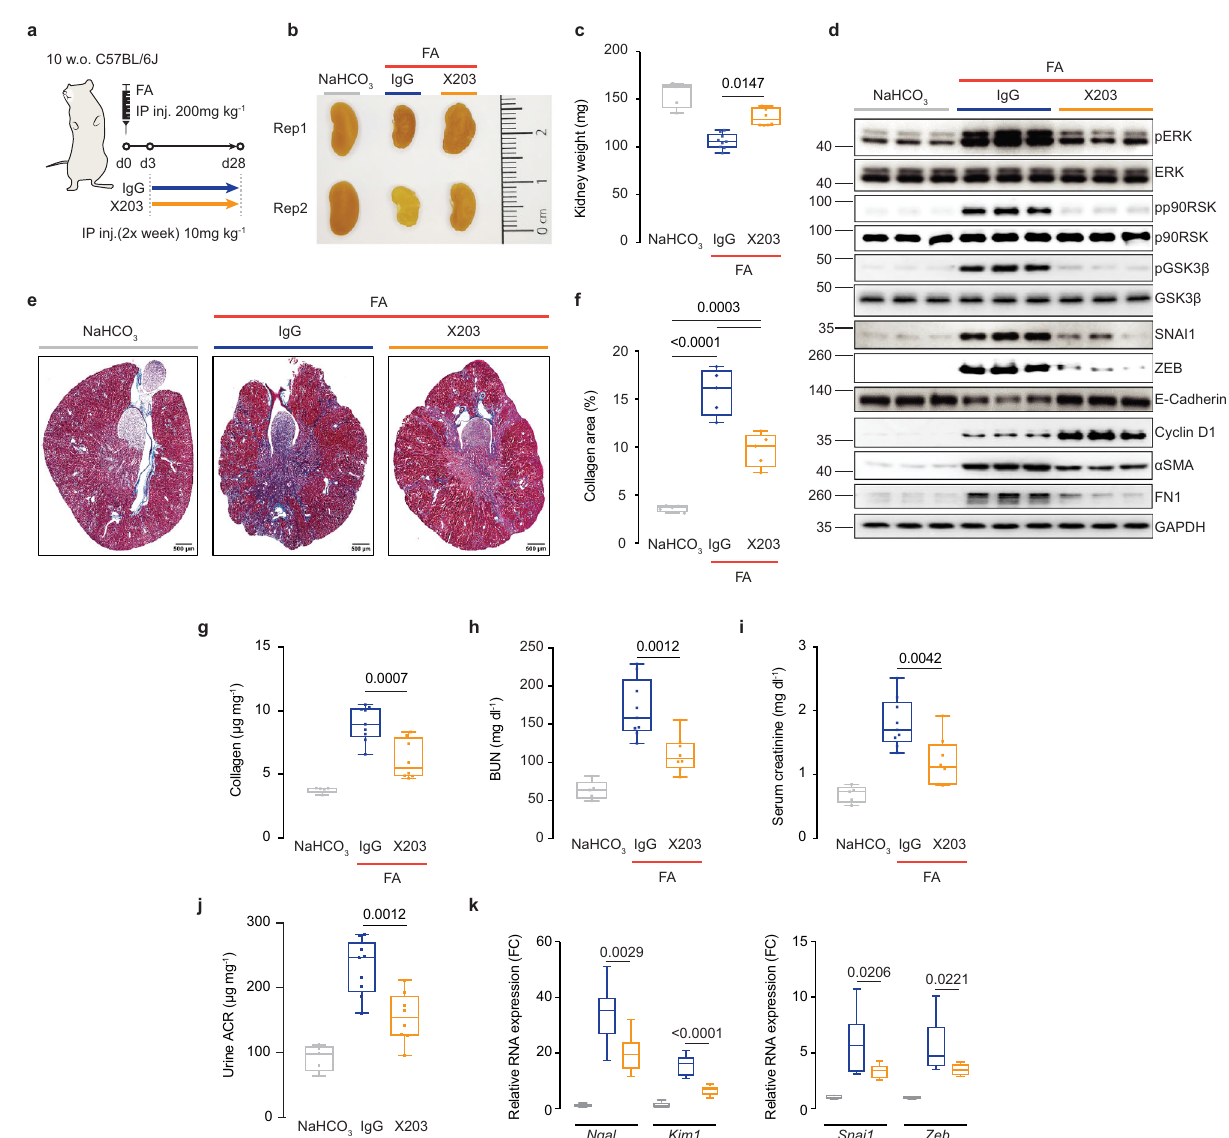
Fig. 4 | Anti-IL11 reduces tubular damage, renal fi brosis and preserves kidney function following folic acid-induced acute kidney injury. a Schematic of X203 therapeutic dosing of FA-injured mice for experiments shown in ( b – k ). IgG/X203 (10mg/kg) was administered biweekly starting from day 3 following FA injury. Blood and kidney phenotypes were analyzed on day 28. b Representative kidney grossanatomy, c kidneyweights, d WesternblotsofpERK,ERK,pp90RSK,p90RSK, pGSK3 β , GSK3 β , SNAI1, ZEB, E-Cadherin, Cyclin D1, α SMA, FN1, and GAPDH (representative dataset from n =5/group), e representative Masson ’ s Trichrome images of whole kidney cross section (scale bars: 500 µ m, representative dataset